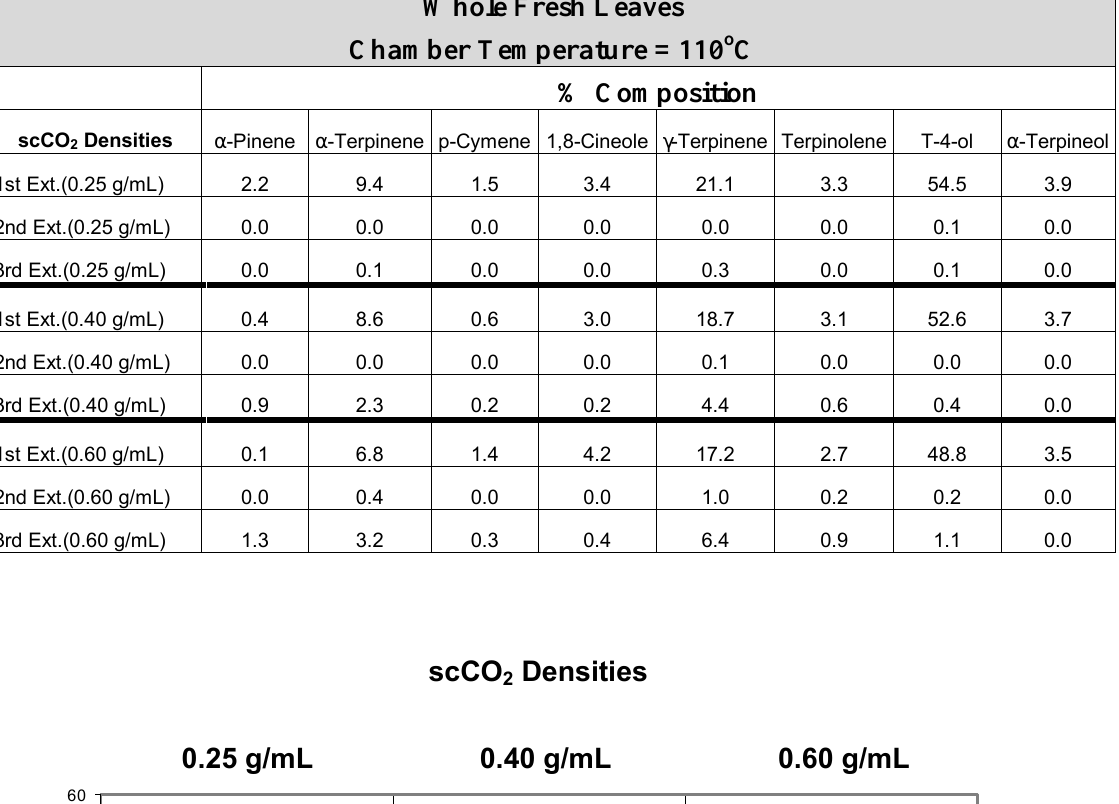
Table 2. Data for whole fresh leaves extracted at a chamber temperature of 110 o C. Whole Fresh Leaves